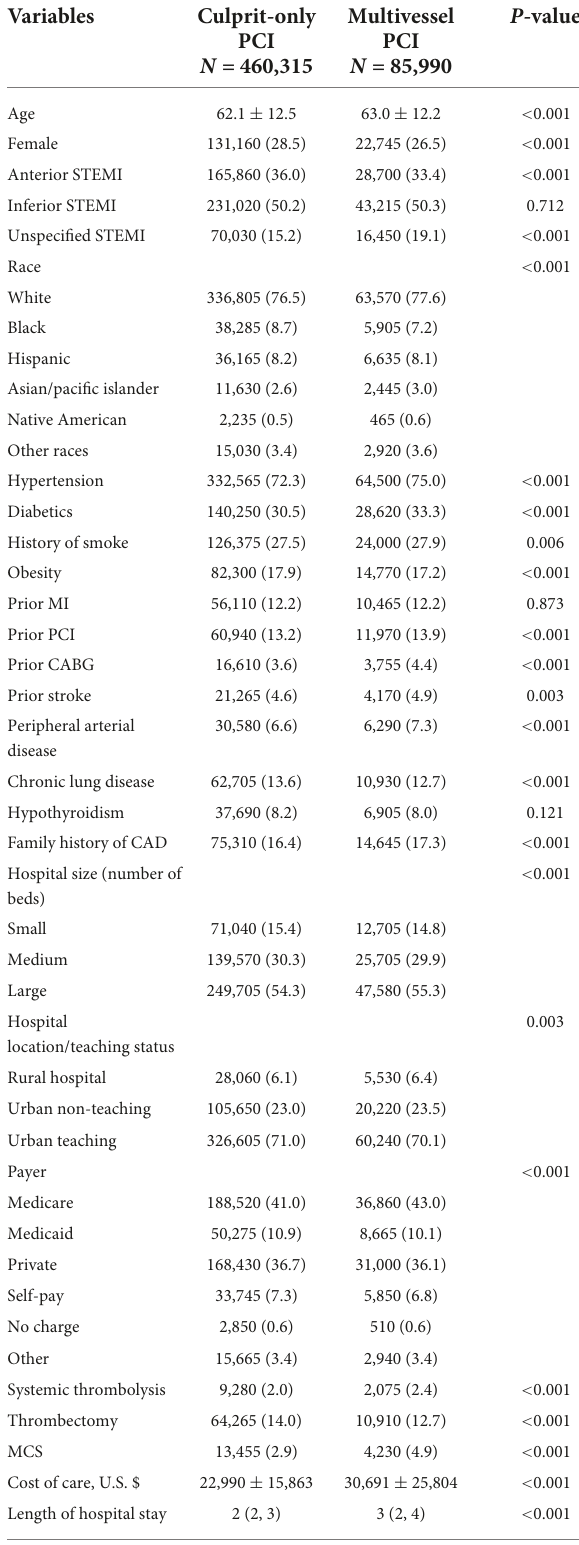
TABLE 2 Baseline characteristics in STEMI hospitalizations without cardiogenic